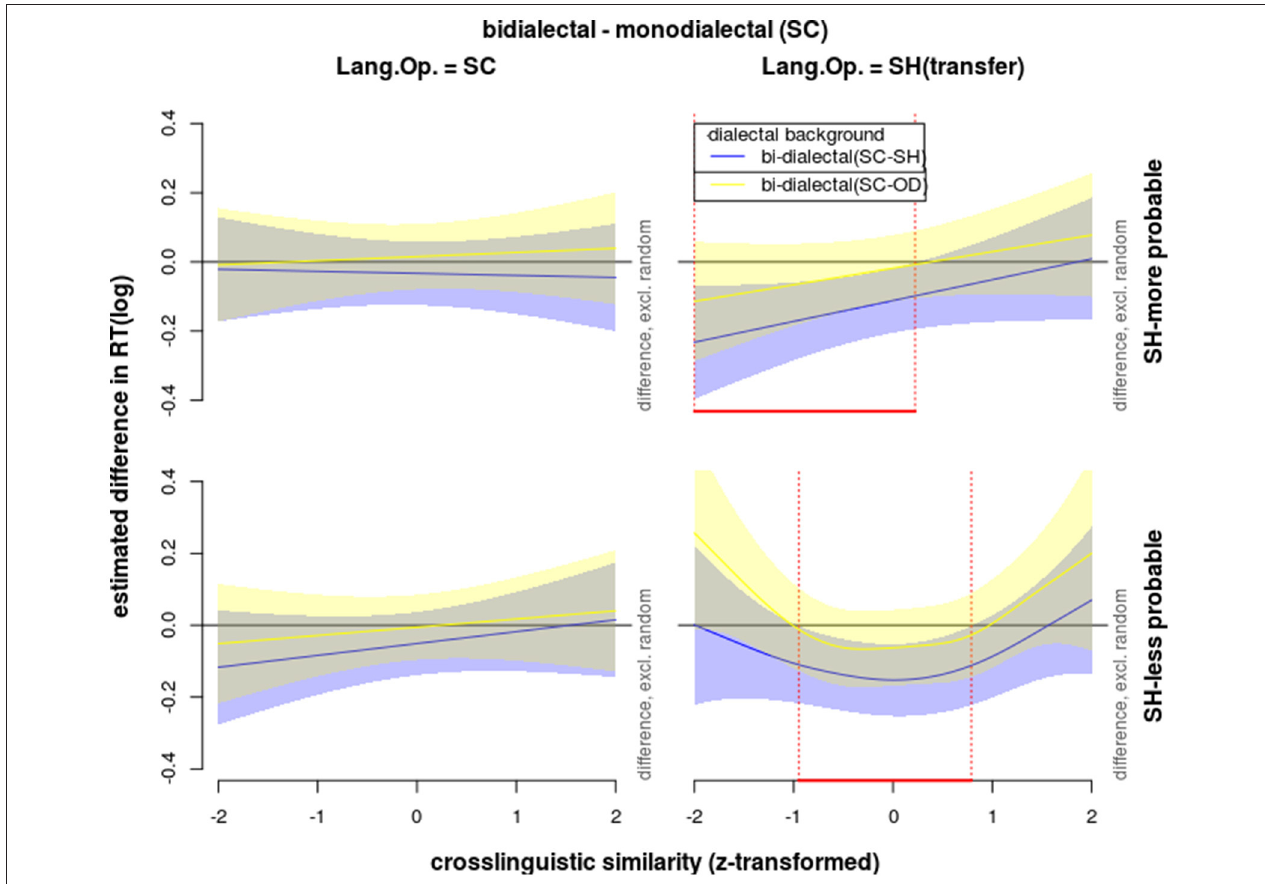
FIGURE 8 | Effects on reaction times in correct responses to word trials during the lexical identification test, modeled with GAM, showing the estimated difference curves comparing SC-SH (blue) and SC-OD bi-dialectals (yellow) against SC mono-dialectals, taking into consideration interactions of cross-dialectal similarity (along the vertical axes), the novel word’s morphological probability in SH (upper = high vs. lower = low subplots), and language of operation (left = SC vs. right = SH